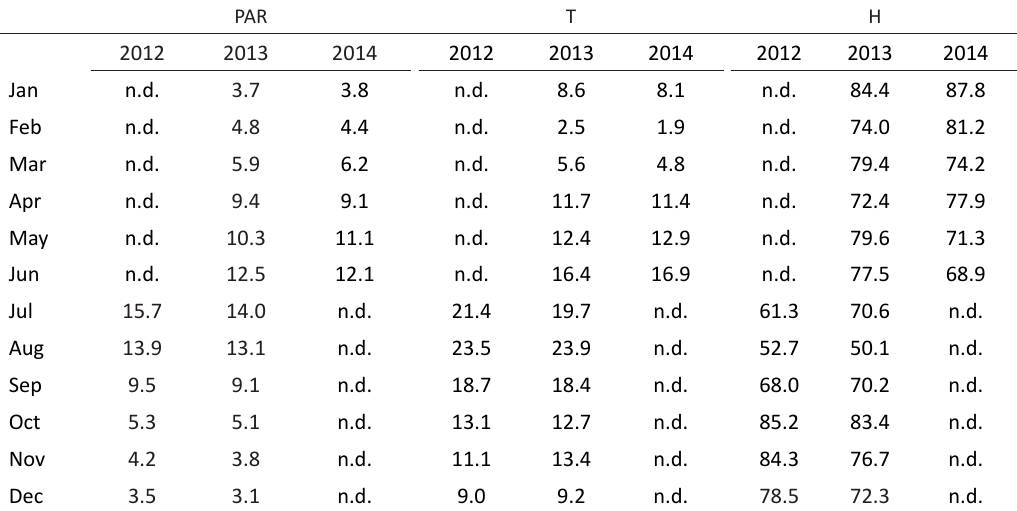
Table 1. Mean daily values of photosynthetically active radiation (PAR, MJ m -2 d -1 ), temperature (T, °C) and relative humidity (H, %) measured in the proximity of the Fragaria vesca cultivation plant; n.d. = data not determined